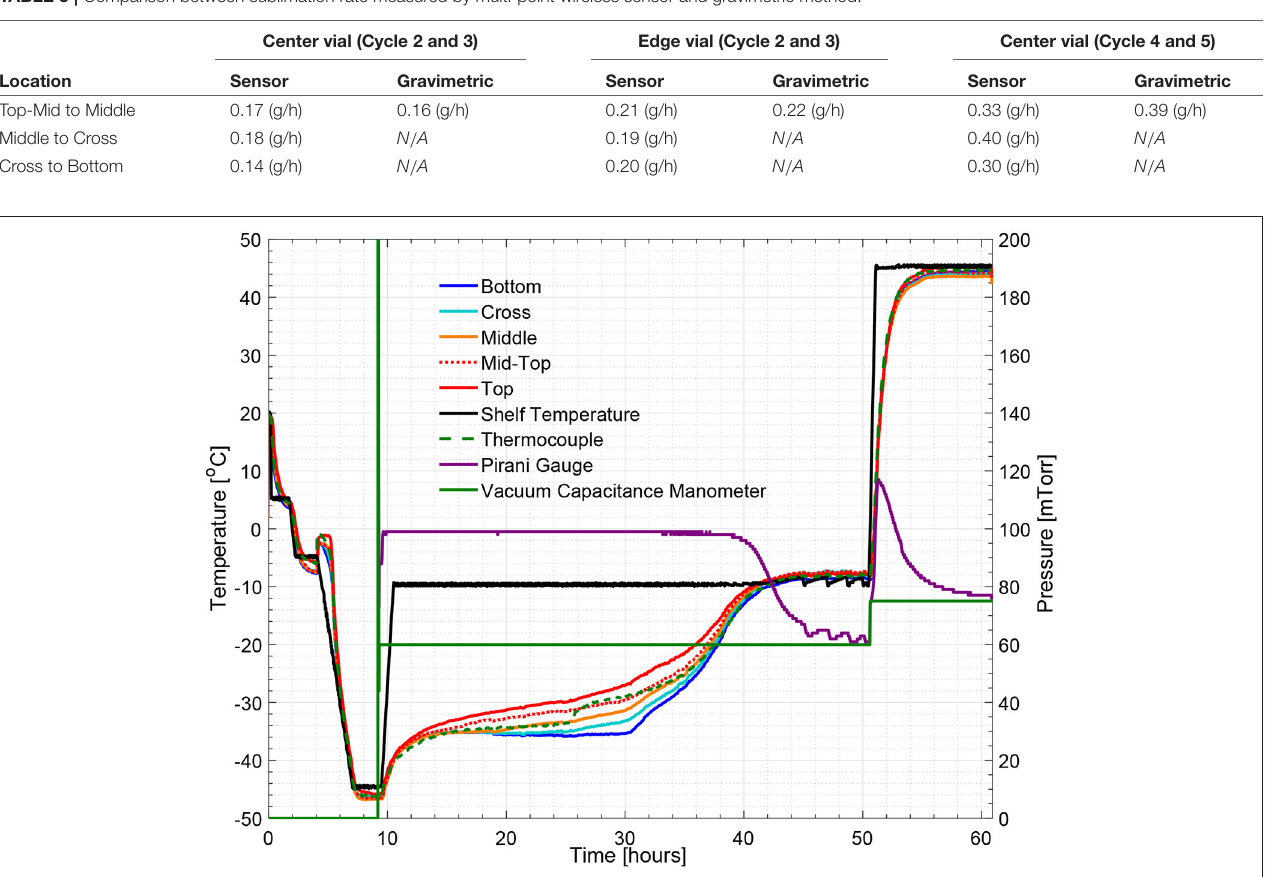
TABLE 3 | Comparison between sublimation rate measured by multi-point wireless sensor and gravimetric method. Center vial (Cycle 2 and 3) Edge vial (Cycle 2 and 3)